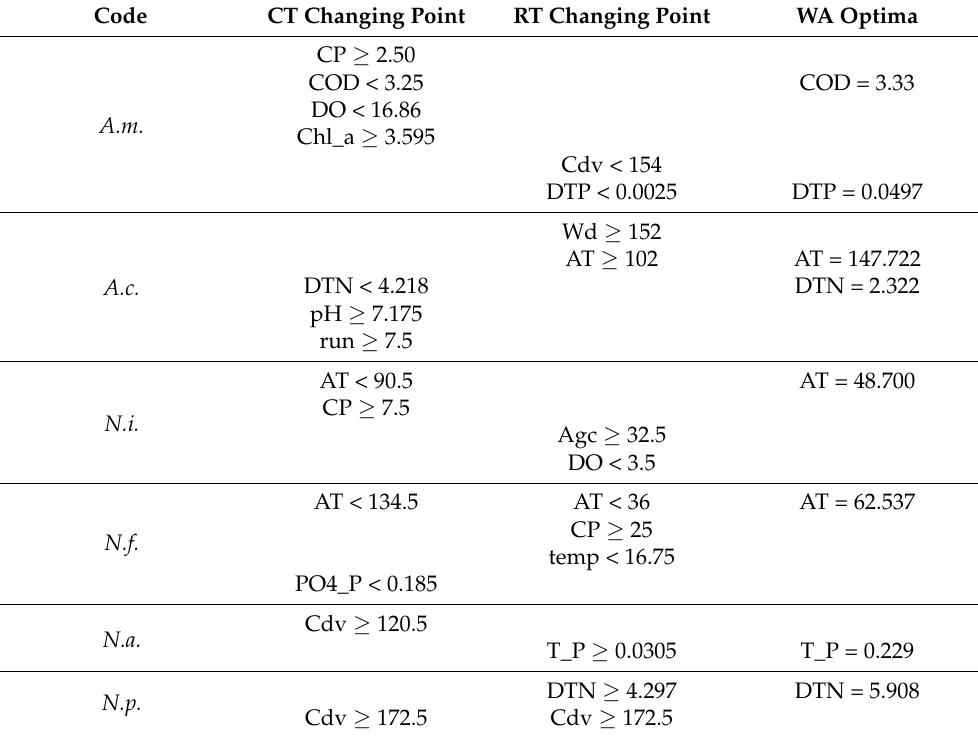
Table 8. Changing point for the classification and regression tree (CART) and the weighted average (WA) optima for six dominant